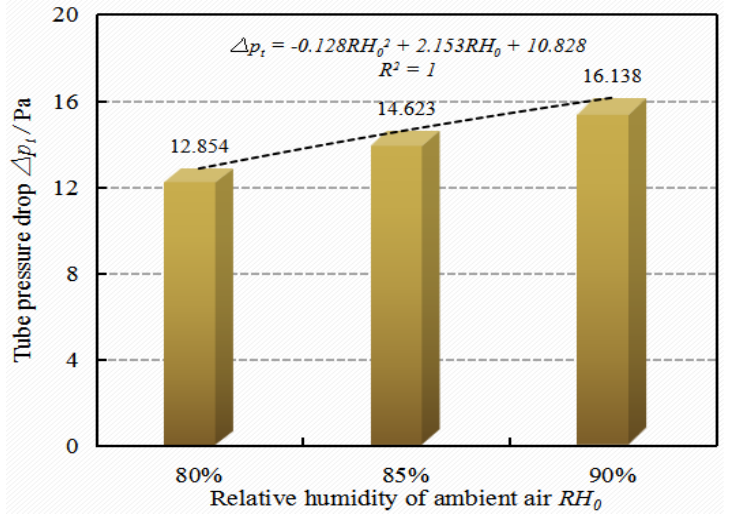
RH values. Figure 11. The variations in ∆ p t with different RH 0 0